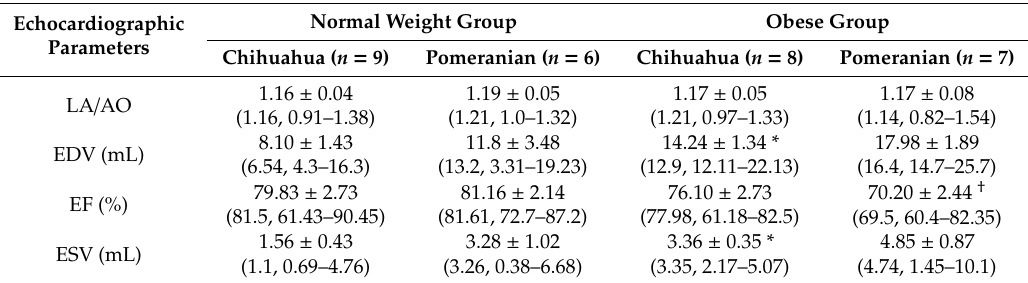
Table 6. Cardiac function from M-mode parameters by breed in normal weight and obese groups. Mean ± SE (median, minimum–maximum) are